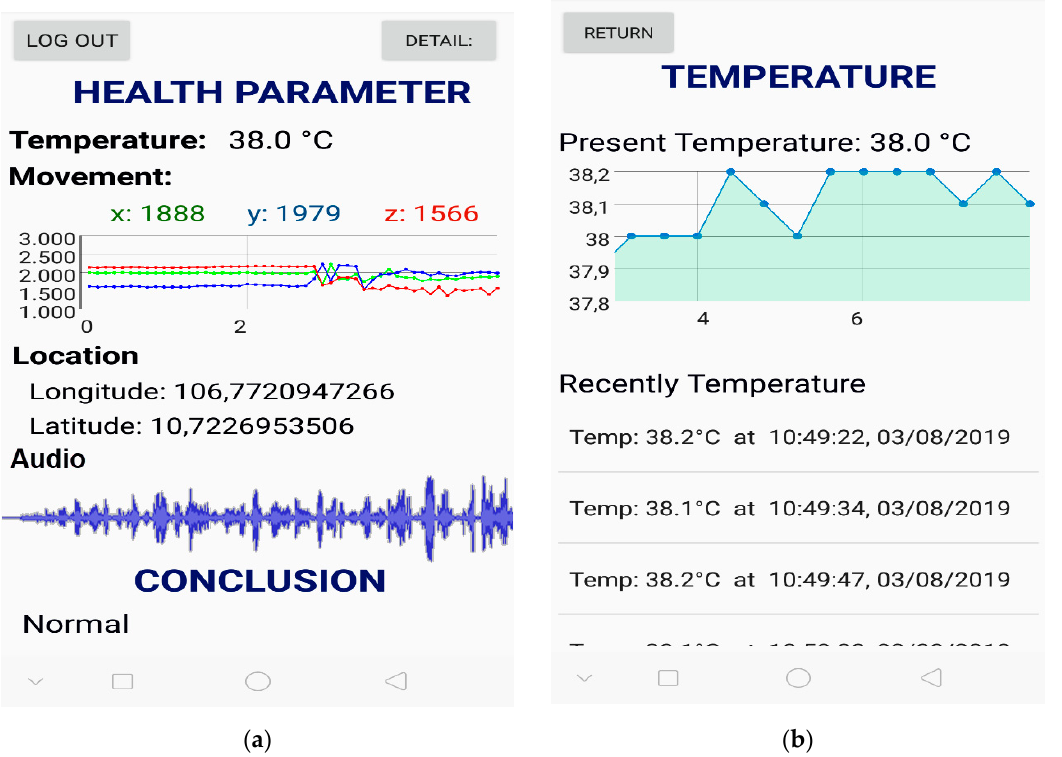
Figure 13. Main graphical user interface ( a ) and temperature data record ( b ).